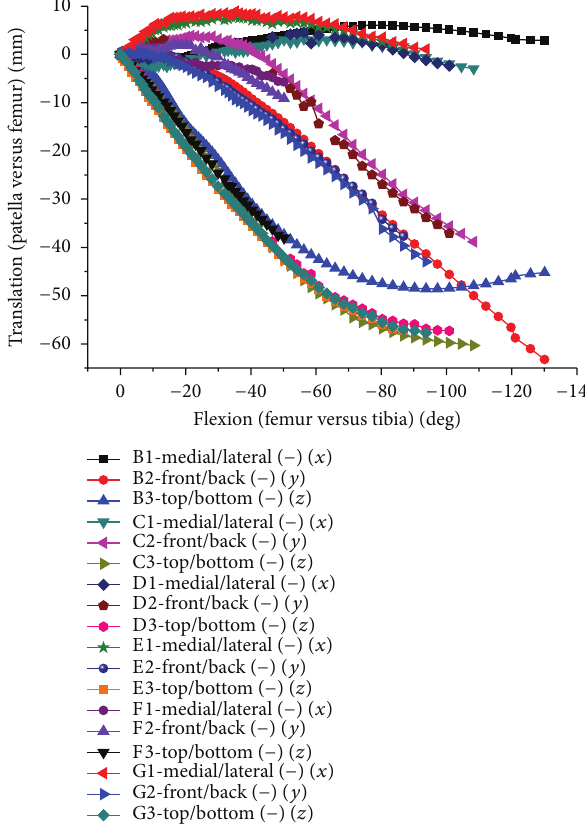
Figure 16: Translation of patellofemoral joint relative movement in both test and